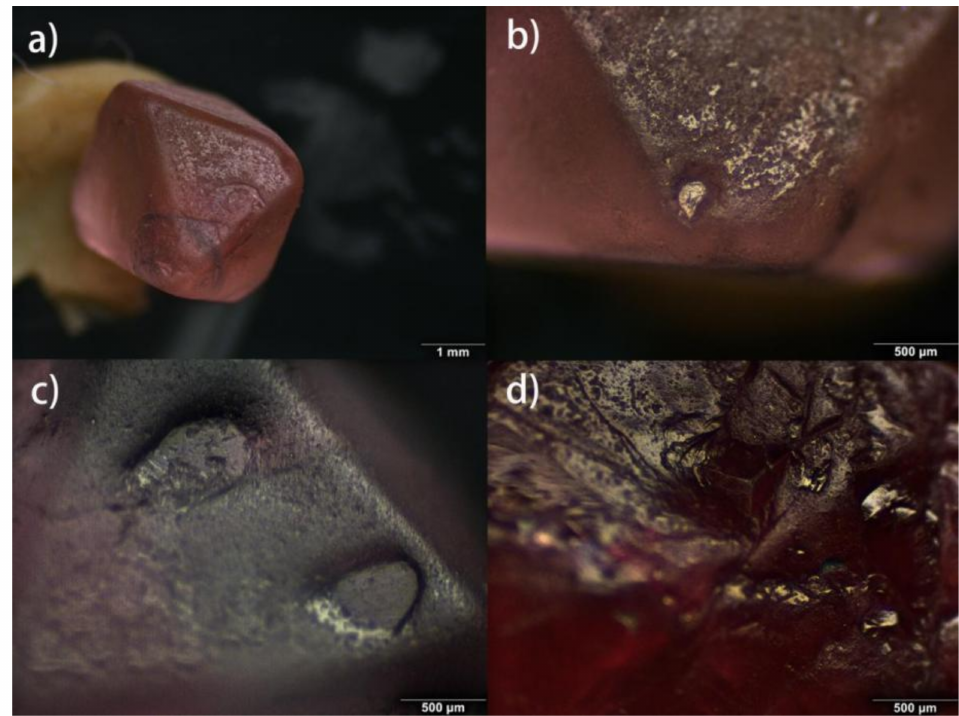
Figure 3. ( a ) Octahedral crystal (M1) ( b ); abraded appearance (M1); ( c ) inverted triangular growth pits (M2); ( d ) cross-growth phenomenon of crystals (M5).